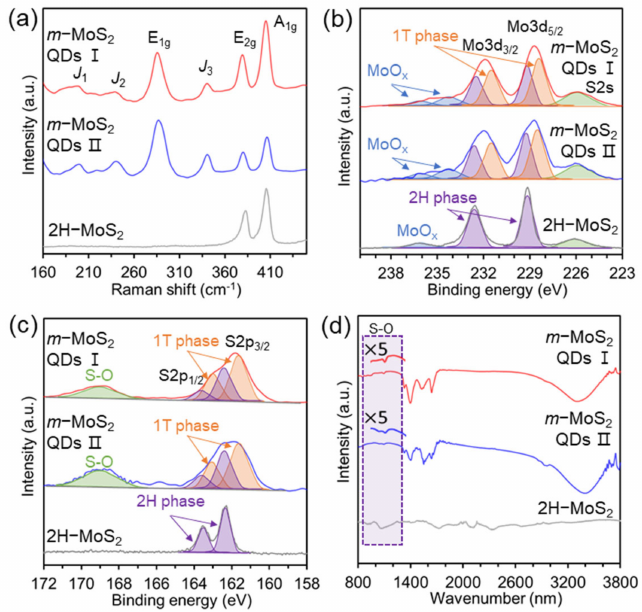
Figure 2. ( a ) Raman spectra of 2H-MoS 2 , m -MoS 2 -QD I, and m -MoS 2 -QD II. XPS spectra of molyb- denum and sulfur elements Mo 3d of 2H-MoS 2 , m -MoS 2 -QD I, and m -MoS 2 -QD II ( b ). S 2p of 2H-MoS 2 , m -MoS 2 -QD I, and m -MoS 2 -QD II ( c ). ( d ) FT-IR spectra of 2H-MoS 2 , m -MoS 2 -QD I, and m -MoS 2 -QD